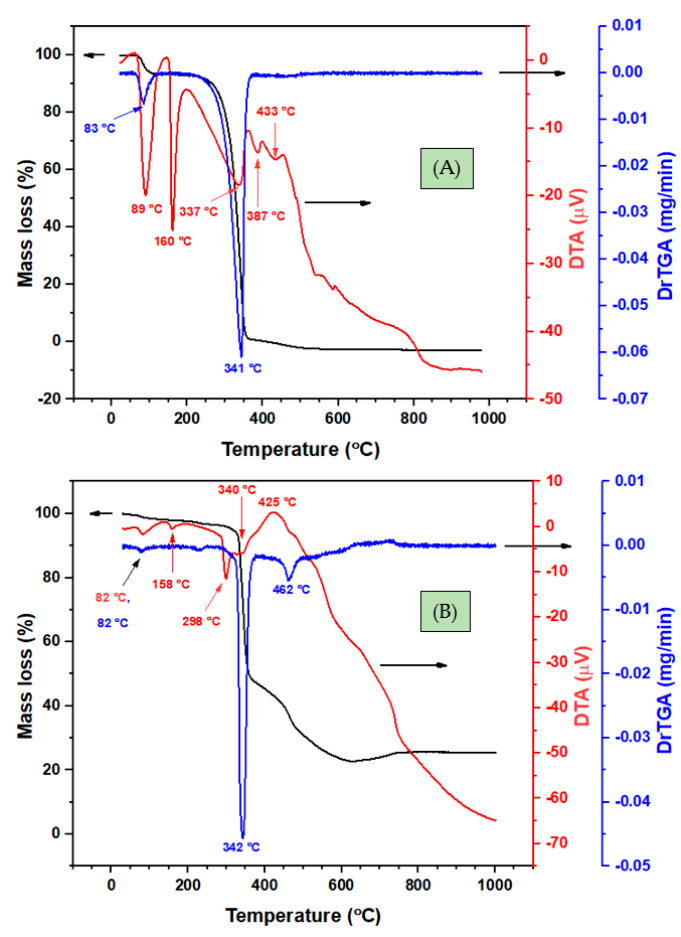
Figure 6. Thermogravimetric analysis (TGA) (black), derivative (Dr)-TGA (blue), and differential thermal analysis (DTA) (red) curves of ( A ) the N'-(4-methoxybenzylidene)benzohydrazide (HL) ligand and ( B ) its nickel complex (Ni(II)-2L).